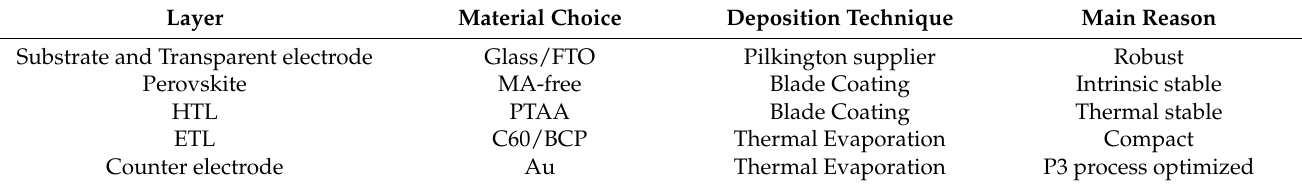
Table 2. Summary of the materials used for modules incorporated into the final perovskite panel. Layer Material Choice Deposition Technique Main Reason Substrate and Transparent